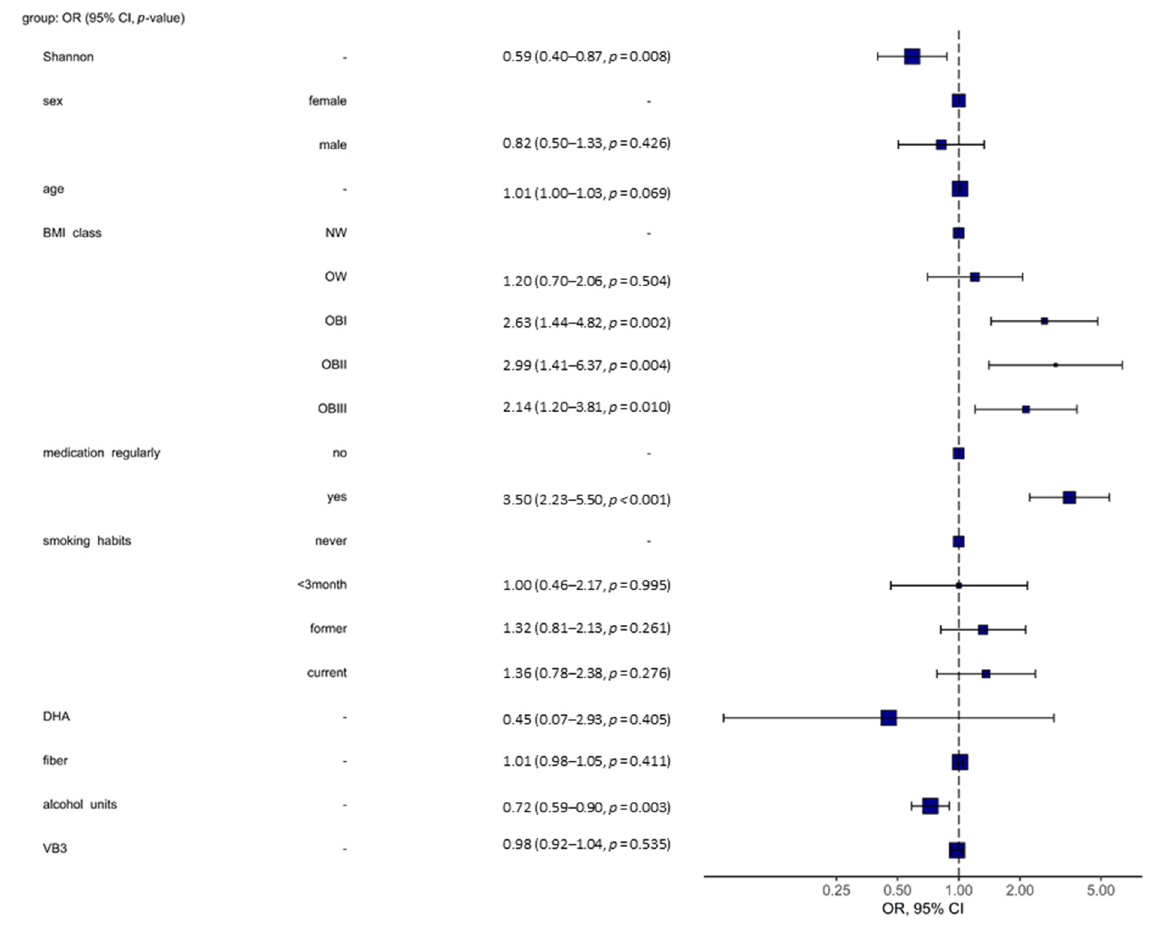
Figure 6. Forest plot showing the odds ratios with corresponding 95% confidence interval and p -values of variables used in a multivariate regression model. Twelve variables were included in the calculation, but vitamin D and vitamin B12 were excluded from this Forest plot due to their extreme odds ratios and corresponding confidence intervals. Reference category was the healthy control group. Figure and calculations were assessed by the “finalfit” package (version 1.0.2) for R in RStudio (version 1.3.1093) with p < 5 × 10 − 2 . NW: normal weight (BMI 18.50 to 24.99 kg/m 2 ); OW: overweight (BMI 25.00 to 29.99 kg/m 2 ); OBI: obesity class I (BMI 30.00 to 34.99 kg/m 2 ); OBII: obesity class II (BMI 35.00 to 39.99 kg/m 2 ); OBIII: obesity class III (BMI ≥ 40.00 kg/m 2 ). Reference category was at all times the first category of the corresponding categorical